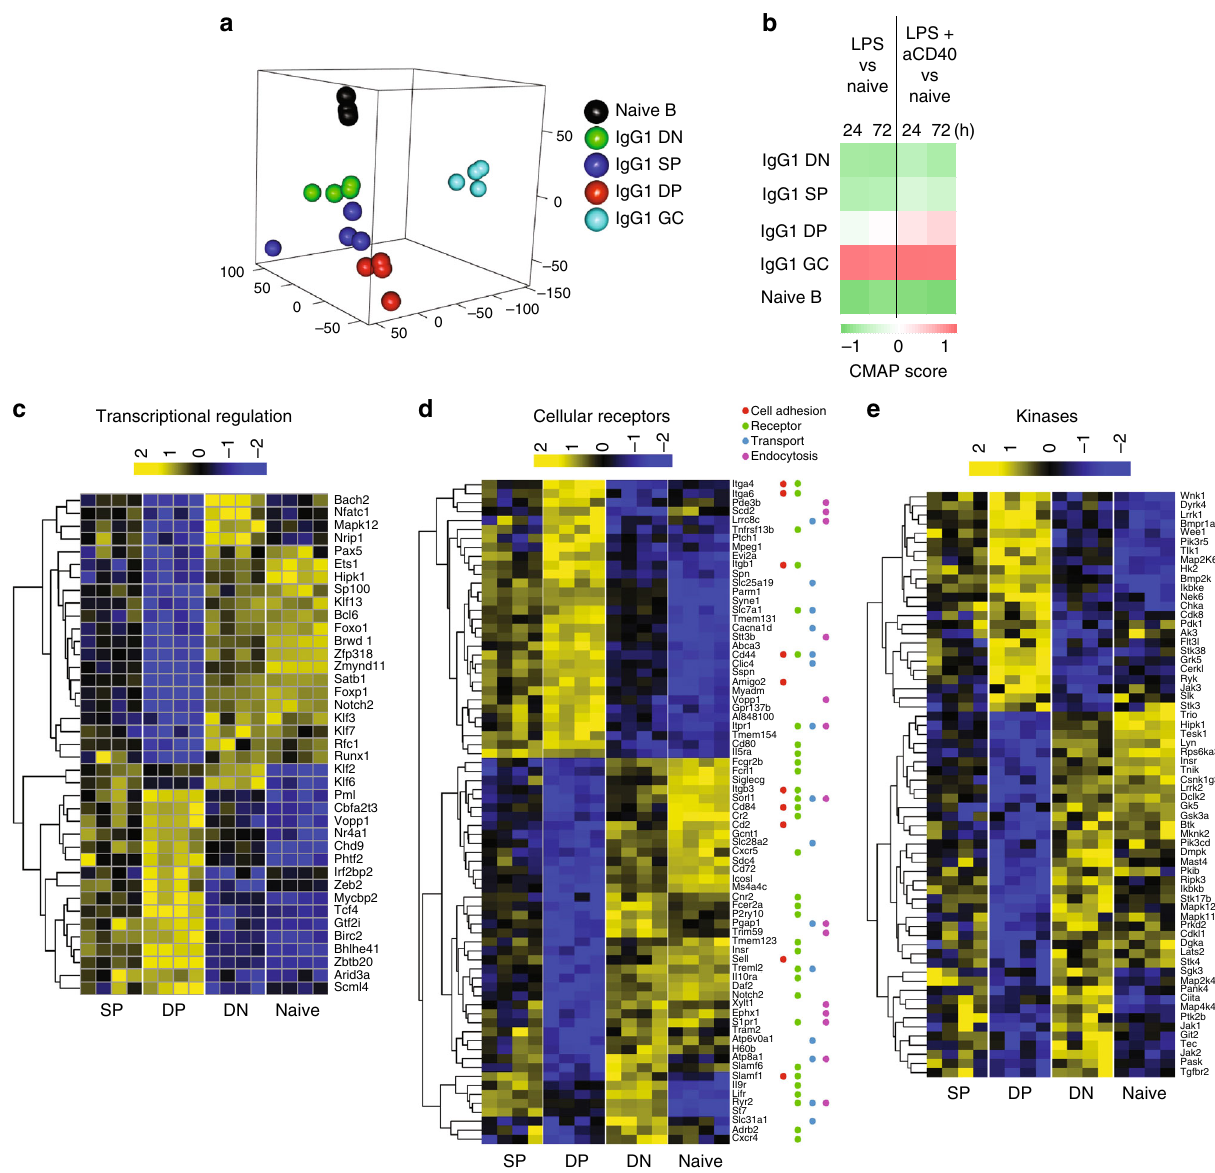
Fig. 6 Transcriptional pro fi le suggests readiness for activation of DP IgG1 MBC. a Inter-sample similarity between DP, SP and DN IgG1 MBC, IgG1 GC cells and naive B cells, visualised as a multidimensional scaling (MDS) plot. b Connectivity map (CMap) analysis to test the similarity of the transcriptional pro fi le of sorted IgG1 MBC, IgG1 GC and naive B cells, with B cells activated with LPS or LPS + CD40 (GSE35998 data set). a – e The B cell populations were sorted from pooled spleen and mLN of 3 BALB/c mice at 10 weeks after infection with N.b . c – e Heatmaps derived from the RNA-seq analysis showed the clustering of DEG related to c transcriptional regulation, d cellular receptors and e kinases, among IgG1 MBC subsets (DP, SP and DN) and naive B cell